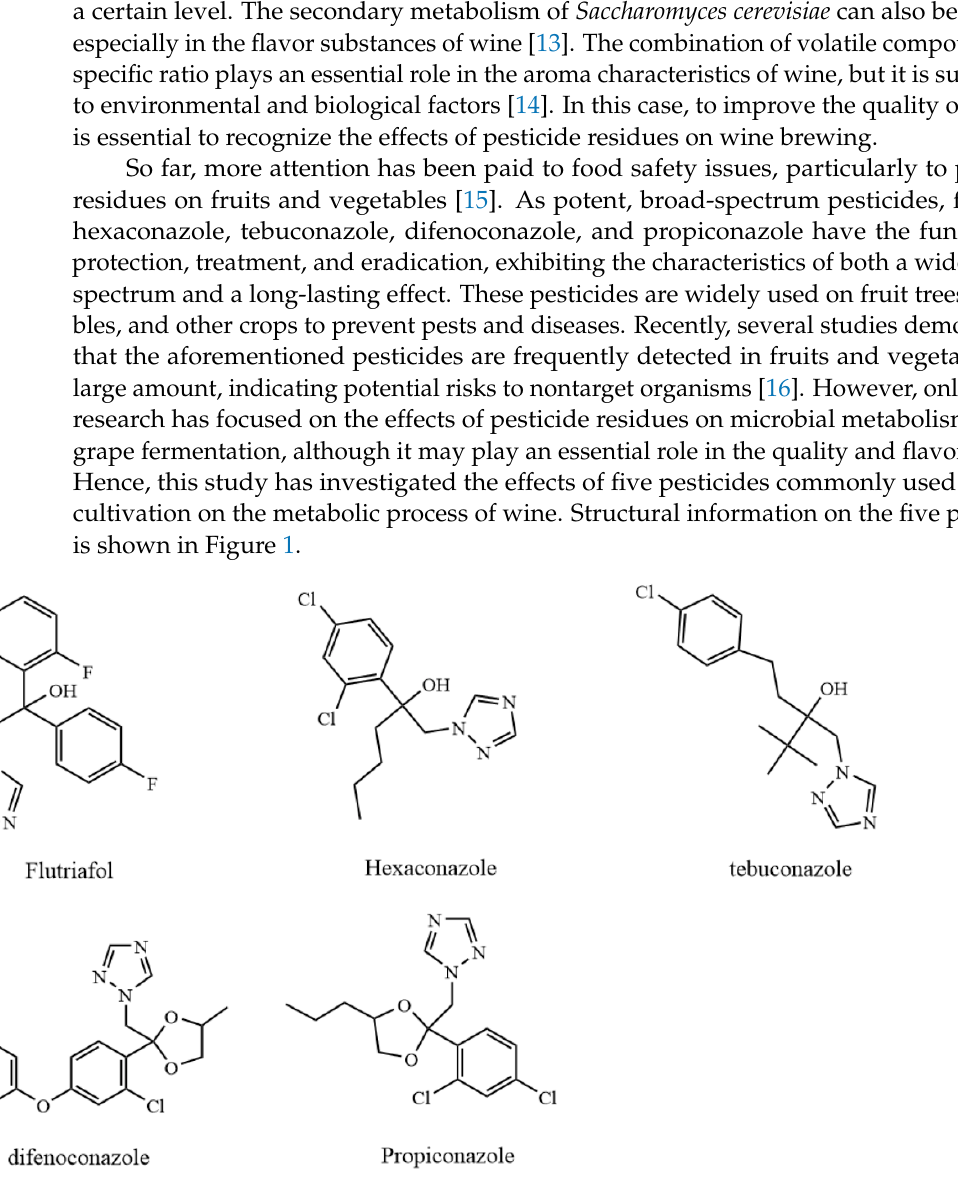
Figure 1. Chemical structure diagrams of five pesticides.